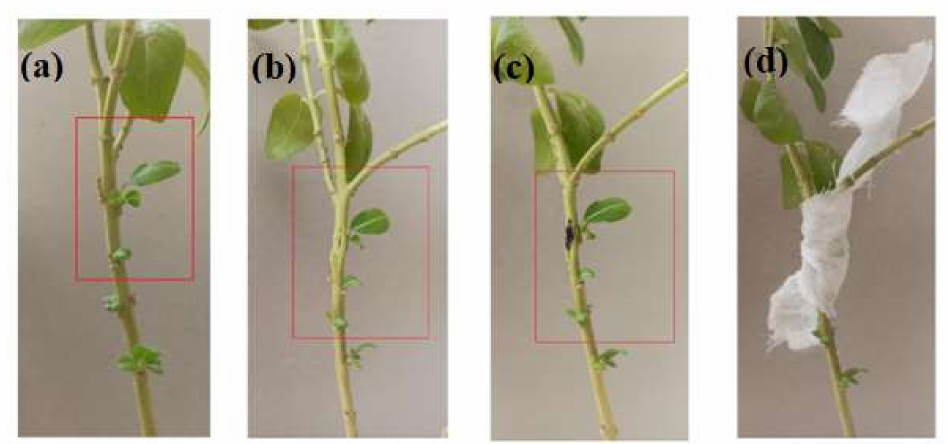
Figure 2. Re-infection of endophytic fungus in a healthy Catharanthus roseus plant, showing ( a ) chosen site for infection; ( b ) creation of wound; ( c ) inoculation of desired endophytic fungus; ( d ) site of infection covered with a muslin cloth.